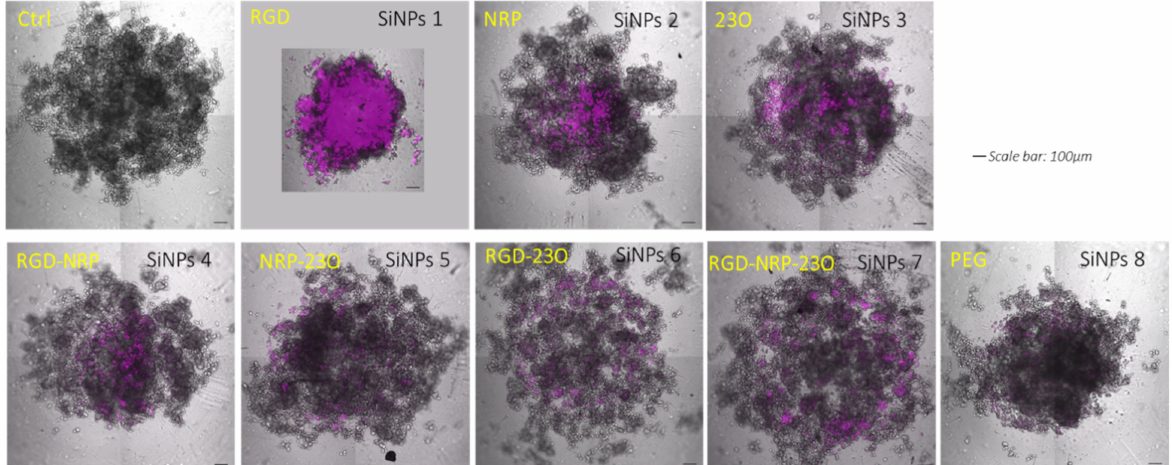
Figure 10. Binding efficiency on spheroids containing M21 human melanoma cells plus endothelial cells. Both M21 melanoma and HUVEC endothelial cells express the a v ß 3 and NRP1 receptors. The binding efficiency of each type of SiNPs on the mixed spheroids was evaluated by fluorescence microscopy after excitation at 633 nm and with an emission filter from 640 to 740 nm, using a 10x